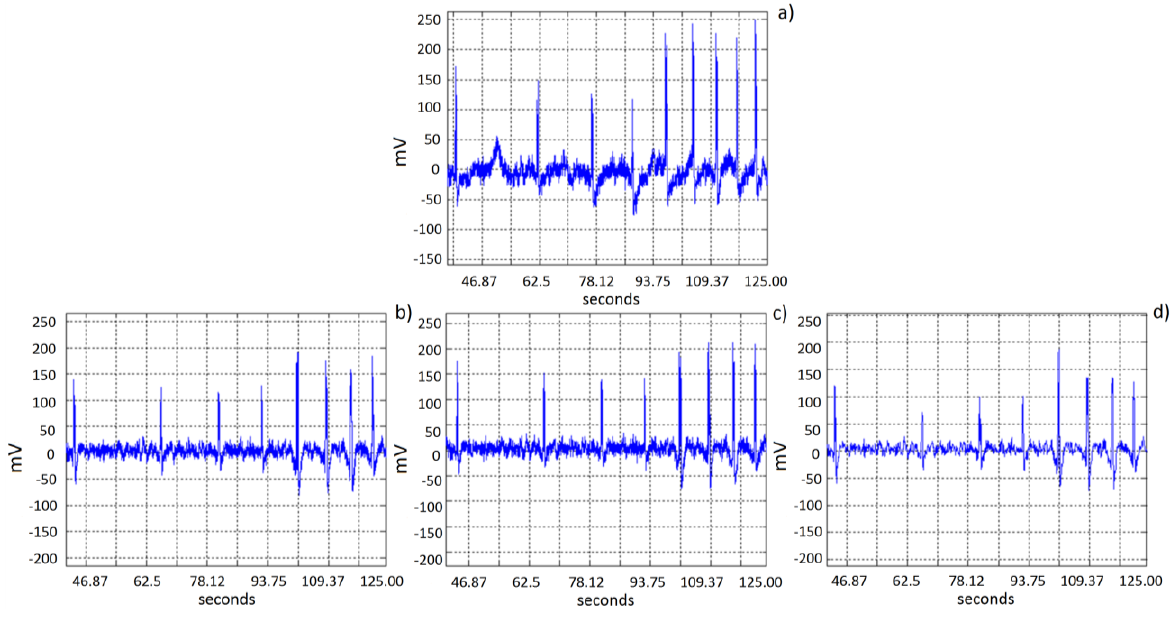
Figure 7. Noise reduction based on correlation function removing, ( a ) 1 IMF, ( b ) 2 IMFs, ( c ) 3 IMFs and ( d ) 4 IMFs.